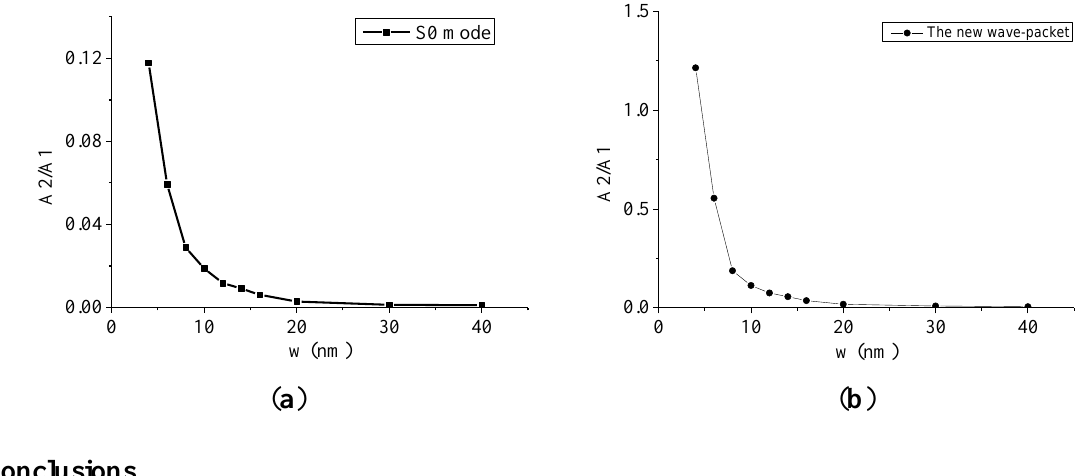
Figure 16. ( a ) The variation of the amplitude ratio with the width of a micro-crack for the S0 mode wave-packet. A2/A1 represents the amplitude ratio; w represents the width of a micro-crack. ( b ) The variation of the amplitude ratio with the width of a micro-crack for the new wave-packet. A2/A1 represents the amplitude ratio; w represents the width of a